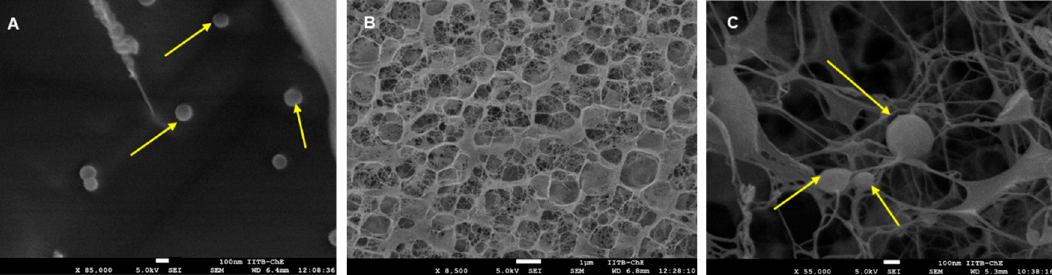
Figure 4. Representative scanning electron microscope images of ( A ) efinaconazole-loaded spanlastic vesicles, ( B ) blank carbopol gel, and ( C ) efinaconazole-loaded spanlastic vesicles loaded into carbopol gel for transungual delivery. Arrows indicate spanlastic vesicles.